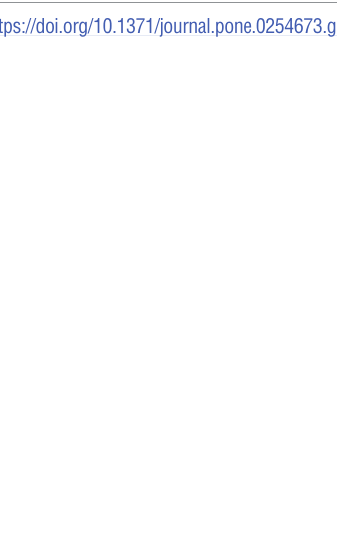
PLOS ONE | https://doi.org/10.1371/journal.pone.0254673 July 16,